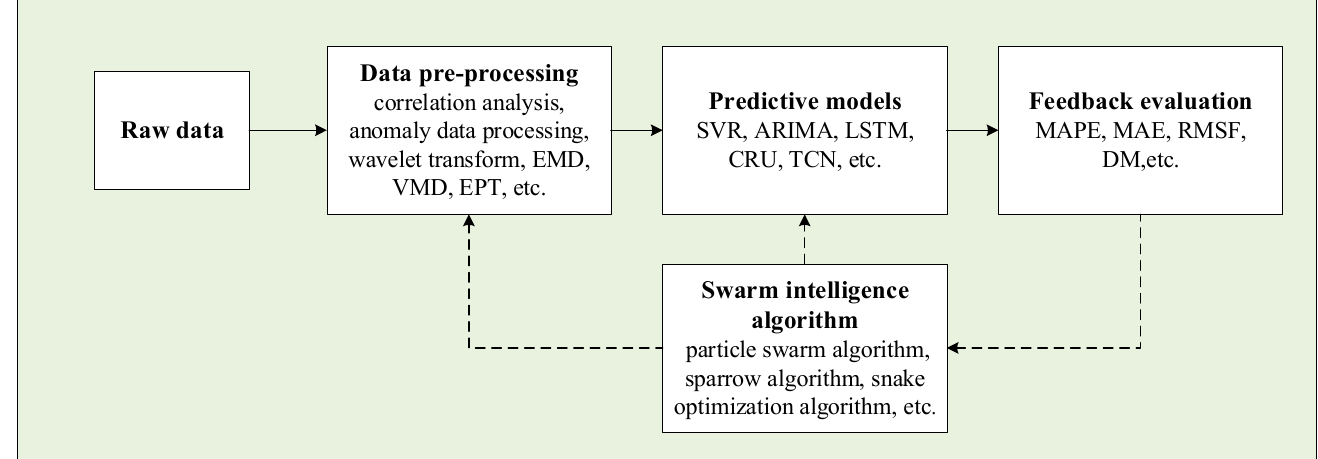
Figure 2. The general flow of power load